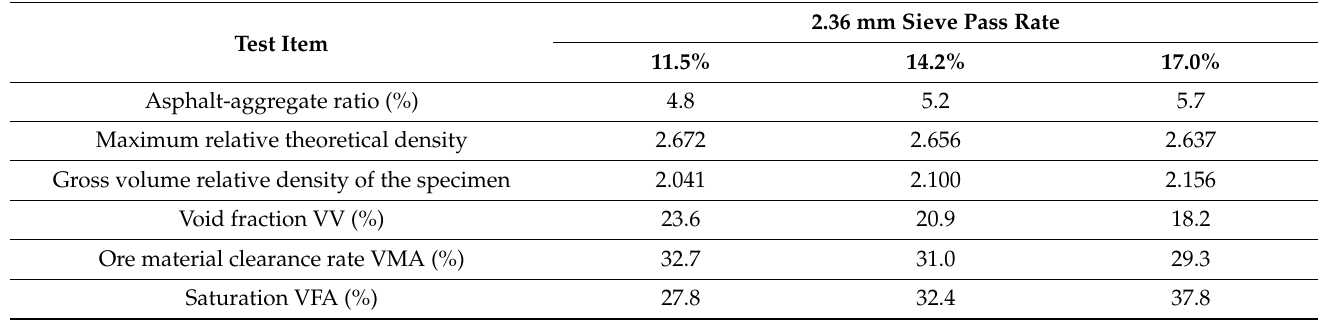
Table 9. OGFC-13 asphalt mixture preliminary gradation Marshall test results.